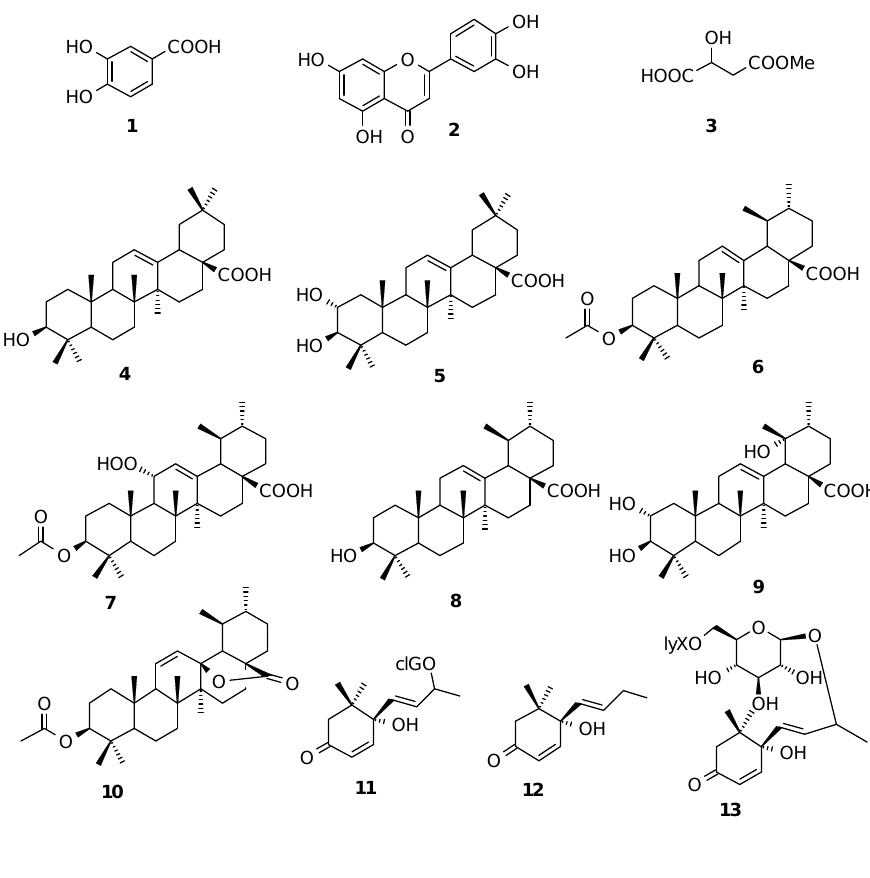
Figure 1. Structures of compounds 1-13 isolated from C. speciosa.